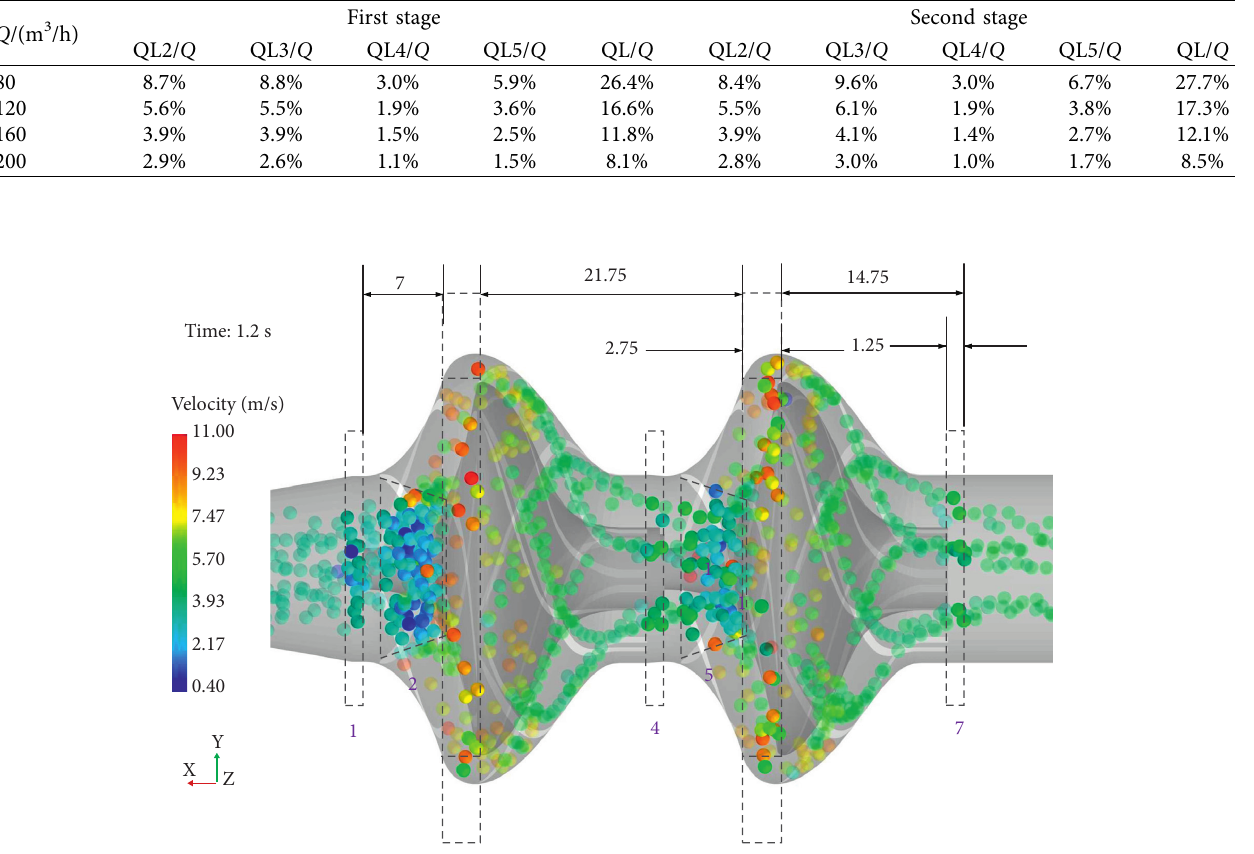
Table 4: Ratio of leakage flow to the total flow at different flow rates.